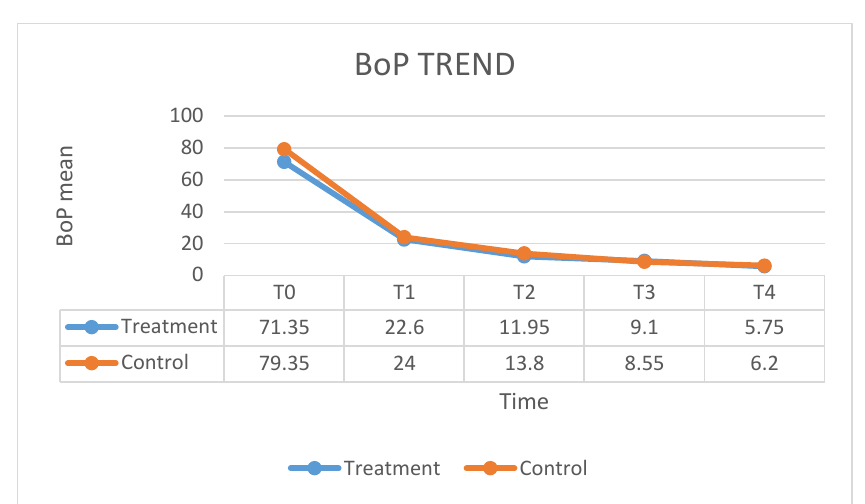
Figure 2. The fluctuation in the PI means over time.